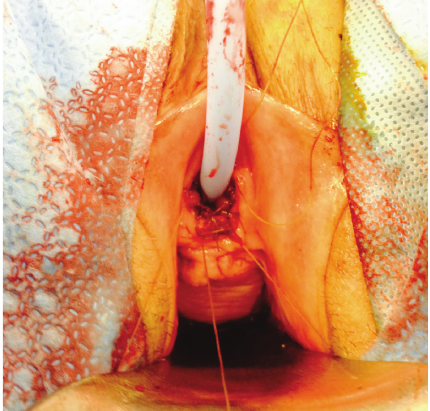
Figure 2: Postsurgical appearance with the prolapsed tissue excised from the healthy urethral margins sutured to the